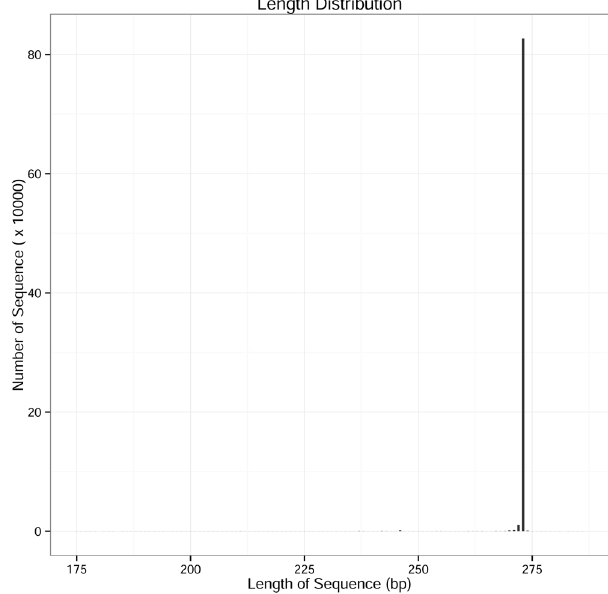
Figure 1. The length distribution of the high quality sequences.